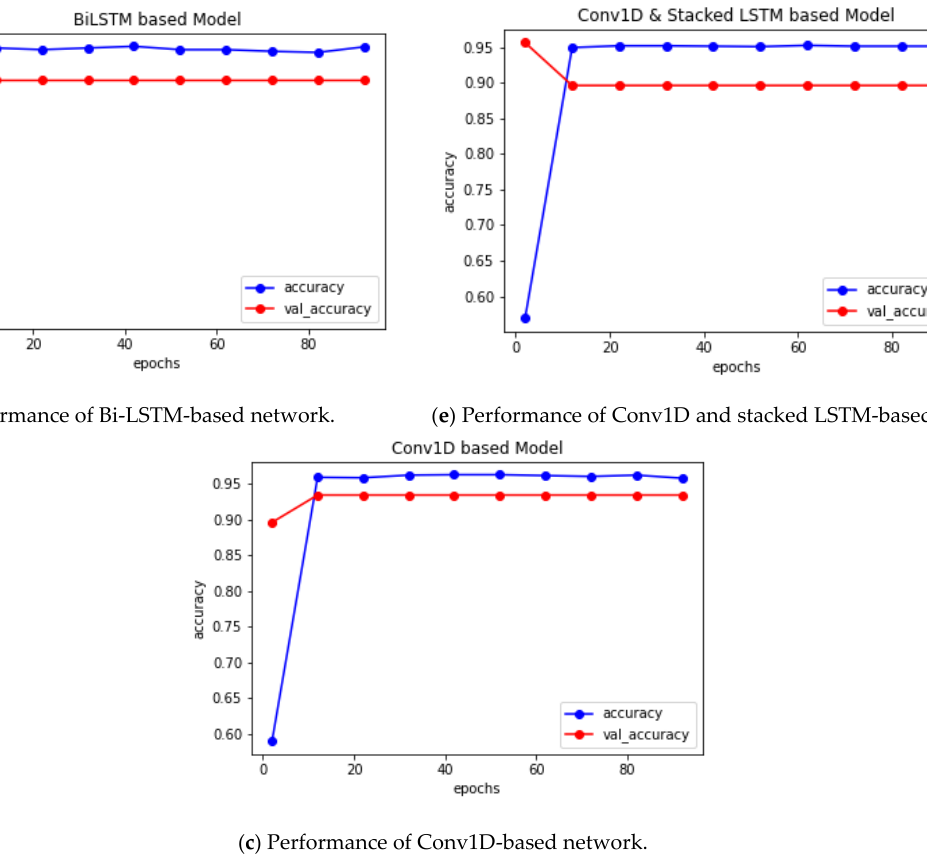
Figure 4. ( a – e ) Graphical illustration of epochs versus accuracy of each network for training and validation dataset.